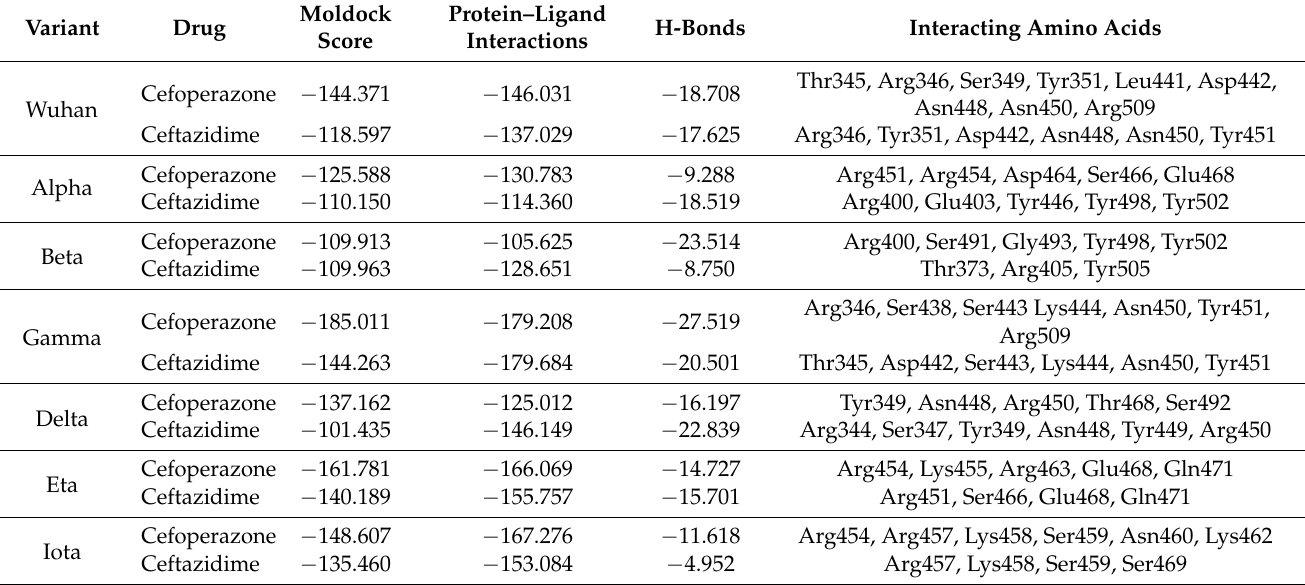
Table 3. Docking of cefoperazone and ceftazidime to the S1 protein of different SARS-CoV-2